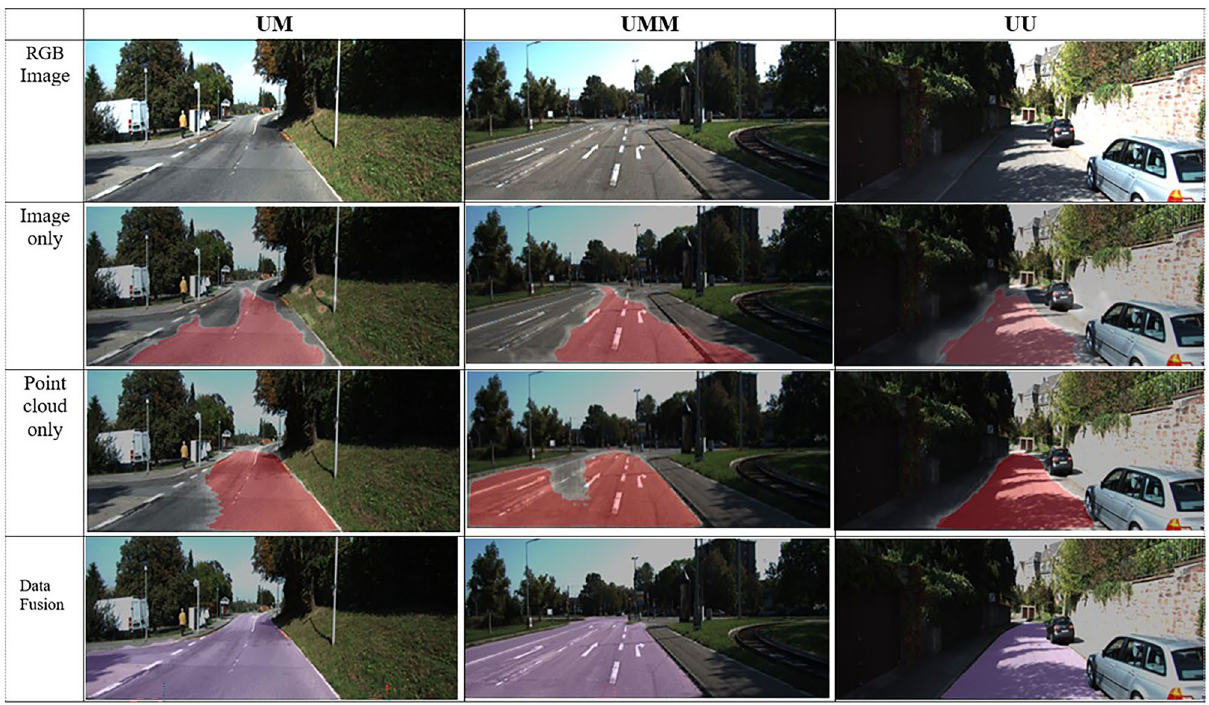
Figure 6. Visual results. The first row to the last row are the original images and the results of the image-based, point cloud-based, and proposed fusion methods, respectively.